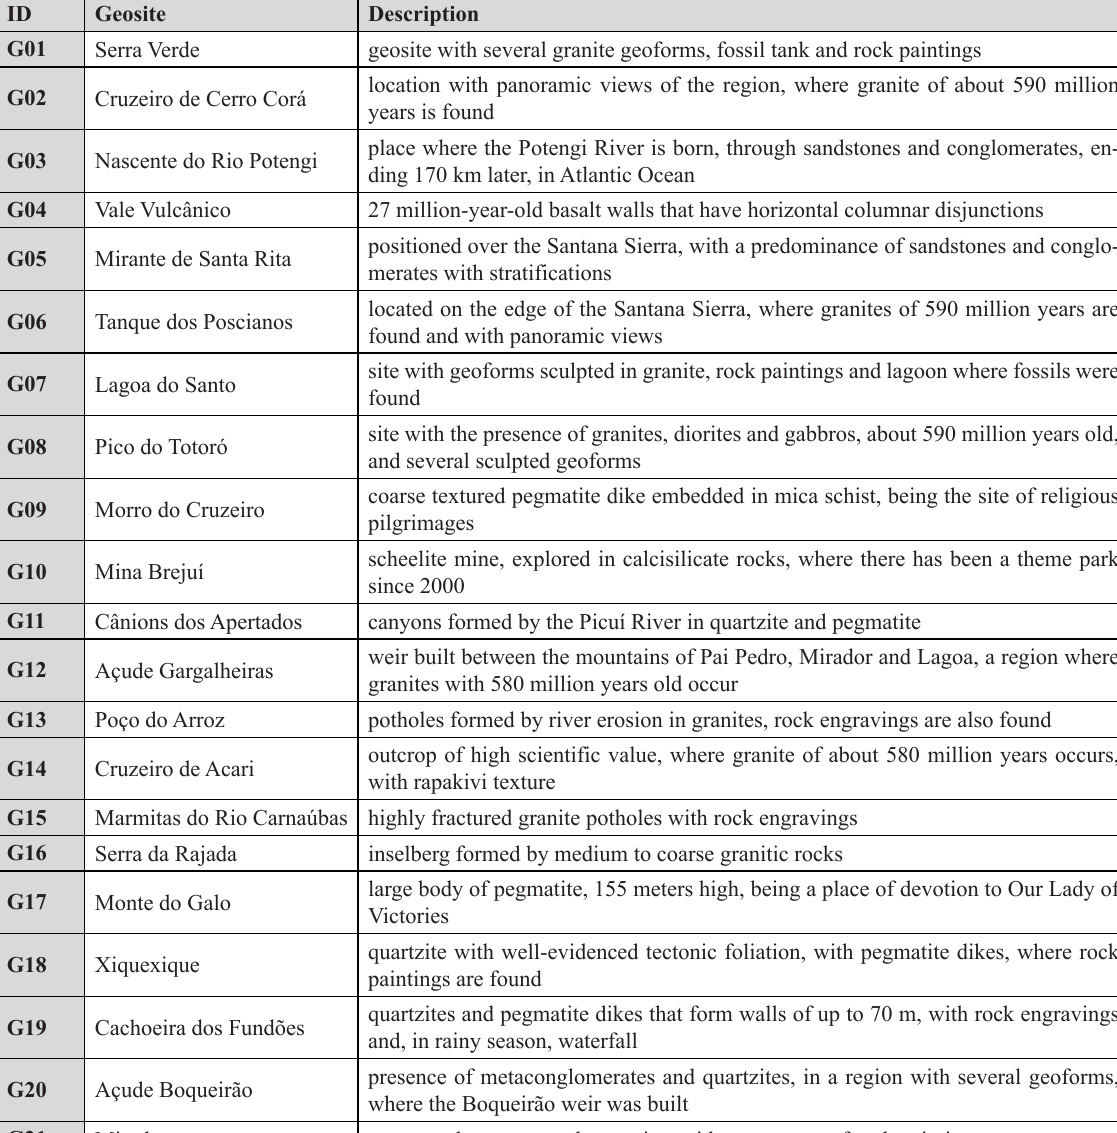
Table 1. Brief descriptions of